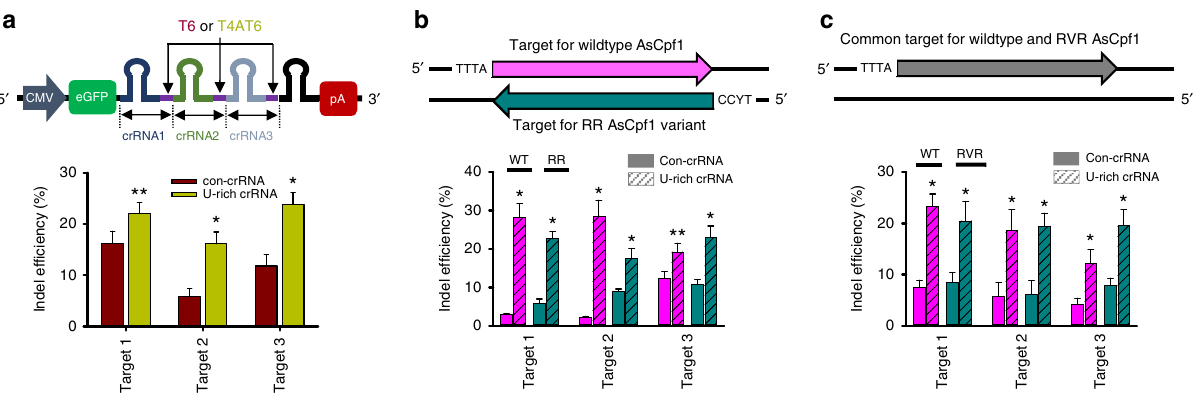
Fig. 5 Applications of the U-rich crRNA to multiplexed genome editing and PAM-divergent AsCpf1 variants. a Simultaneous improvements of the indel ef fi ciencies of multiple targets by an array of U-rich crRNAs. crRNA-encoding sequences with three different targets and one scrambled one were cloned into the 3 ′ -UTR region of the eGFP gene in the pEGFP-C1 vector (Clontech). The U-rich crRNAs have target sequences with a 20-base match plus an additional T4AT6, while each control crRNA only has 23-base match target sequences. HEK-293T cells were transfected with 5 μ g each of Cpf1-encoding and crRNA-encoding vectors. The indel ef fi ciency was calculated after normalization with the transfection ef fi ciency as assessed by the green- fl uorescent cell counts. b , c Application of U-rich crRNA to AsCpf1 PAM variants. * p < 0.001, ** p < 0.01 ( n = 3), two-tailed Student ’ s t test. b Three targets were selected as common targets for the WT and RR variant of AsCpf1, which have TTTA and TYCC PAM sequence in each strand. The indel ef fi ciency of WT AsCpf1 or the RR variant was investigated in the presence of the canonical or U-rich crRNA. * p < 0.001, ** p < 0.01 ( n = 3), two-tailed Student ’ s t test. c Three different targets with a TTTA PAM sequence were subjected to indel mutation by transfecting HEK-293T cells with the WT or the RVR variant of AsCpf1, each of which was guided by either canonical or U-rich crRNA. * p < 0.001, ( n = 3), two-tailed Student ’ s t